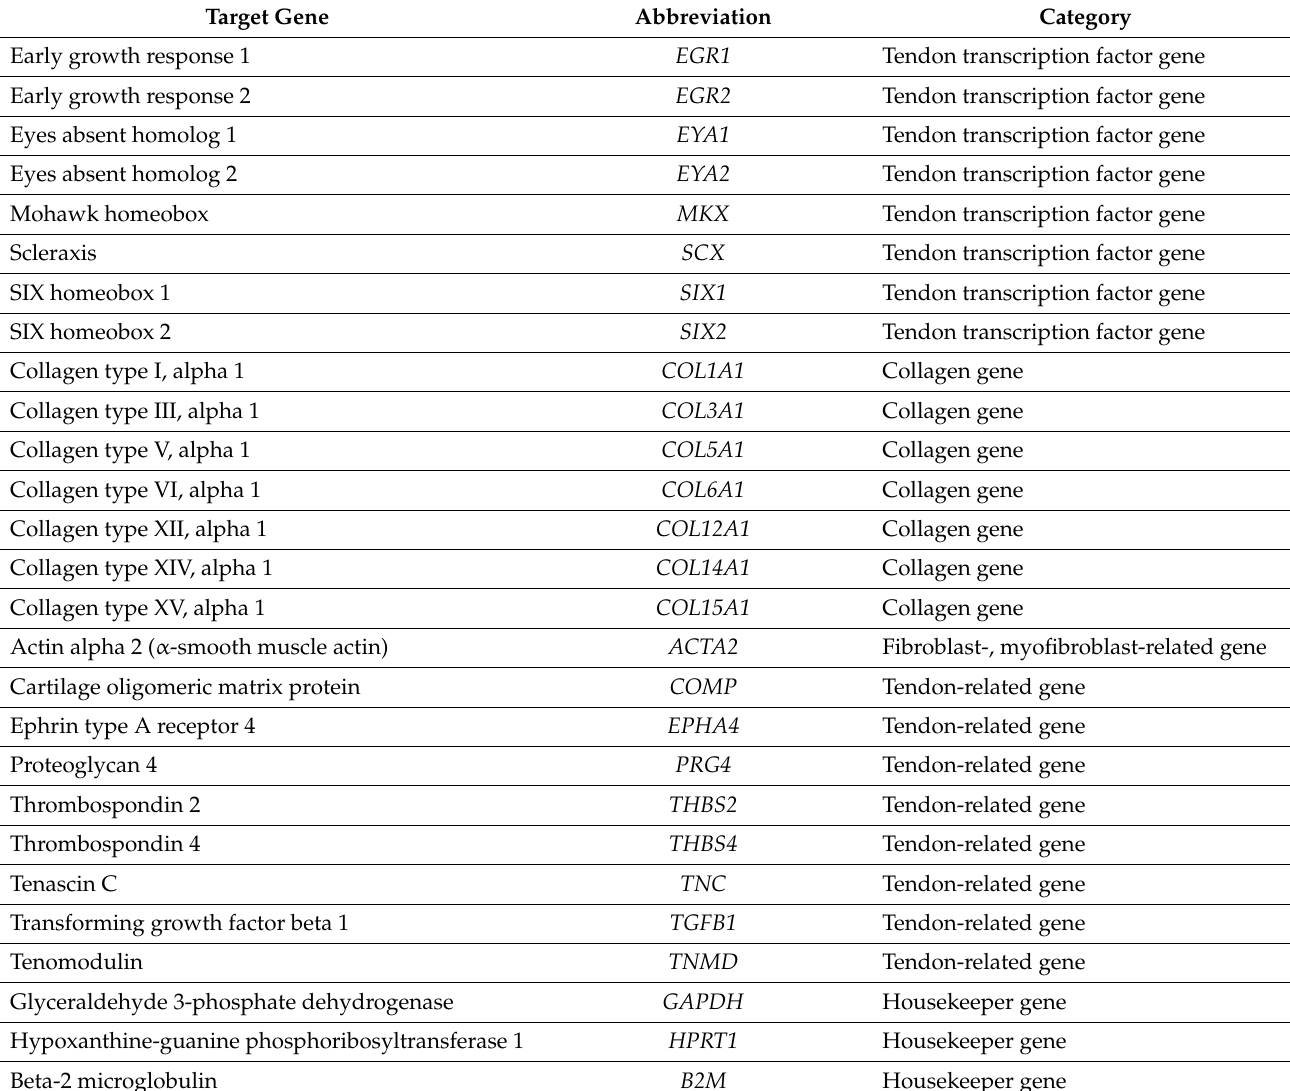
Table 2. Gene list in custom-designed real-time PCR